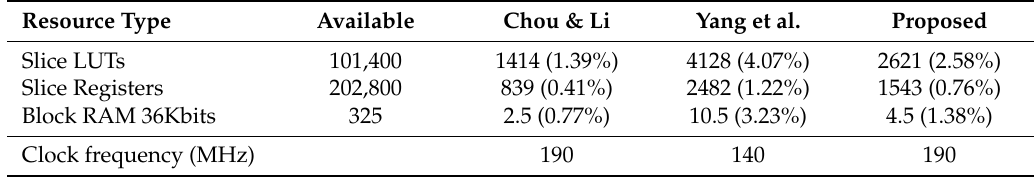
Table 6. FPGA resource utilization and clock frequency comparison of three JND models: Chou and Li’s model, Yang et al.’s model and the proposed